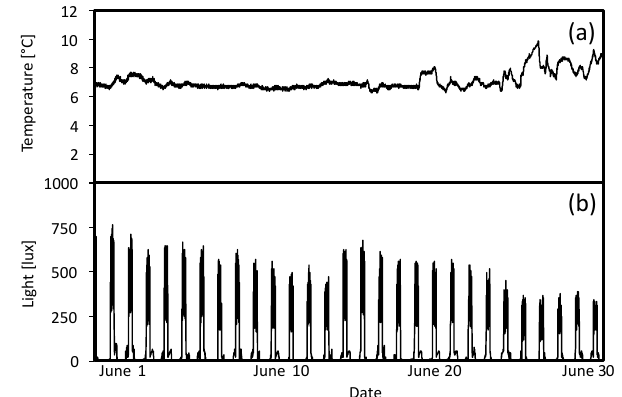
Figure 7. (a) Temperature ( ◦ C) and (b) light (lux) during June in high-light portion of 7 ◦ C tank.